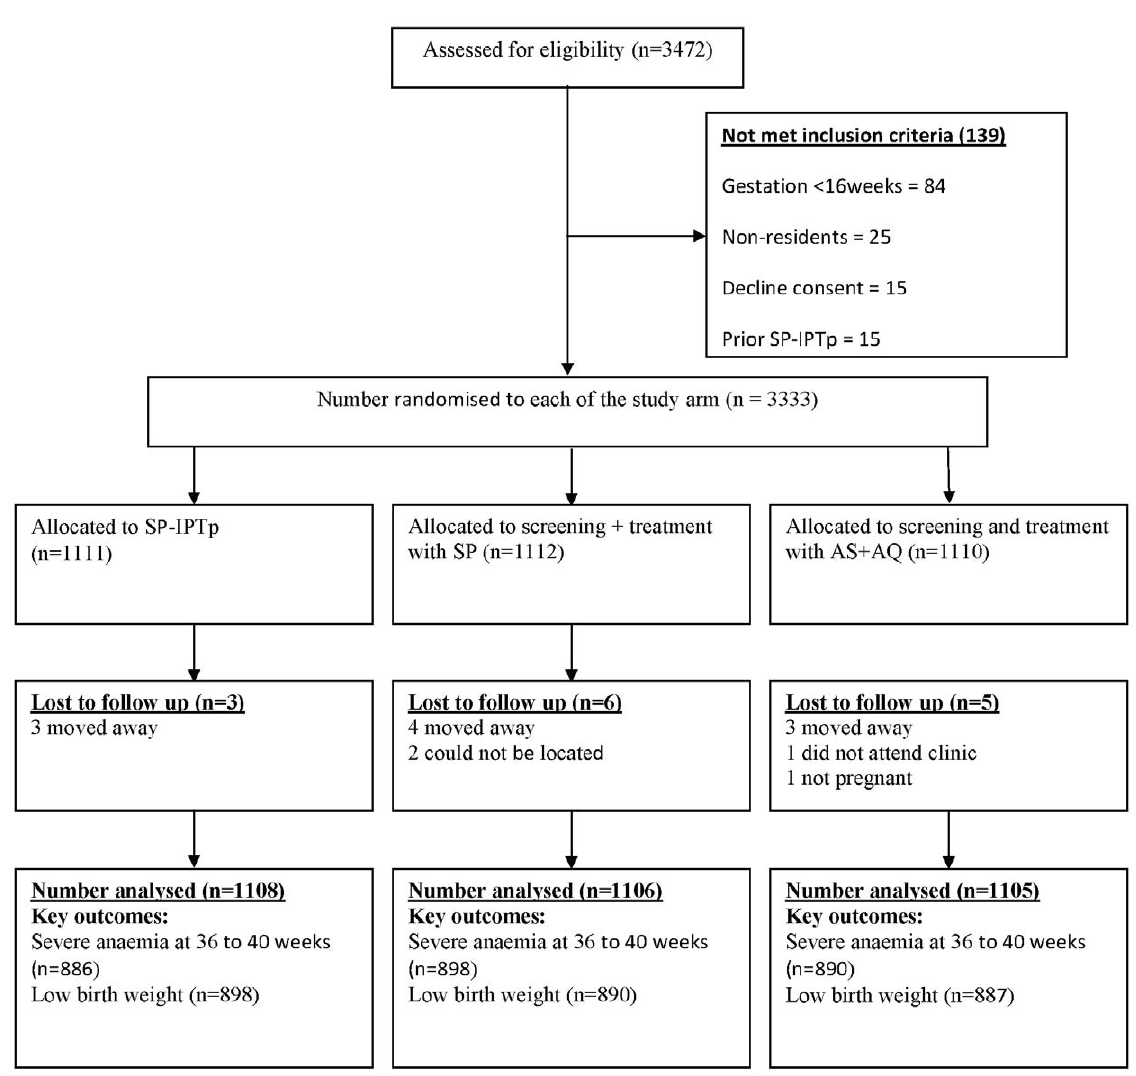
Figure 1. CONSORT chart showing enrolment and follow-up status of women in each study arm.